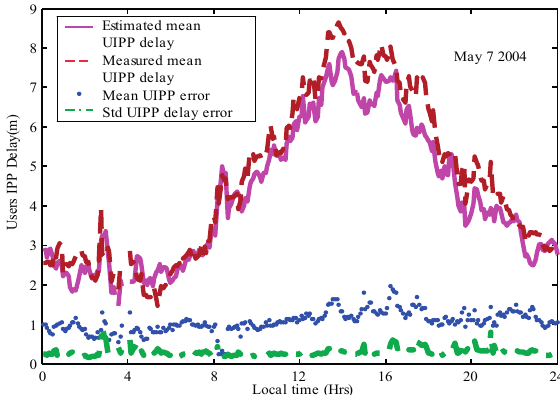
Fig. 3. Estimated mean UIPP delay and mean error using bilinear interpolation technique (7 May 2004)